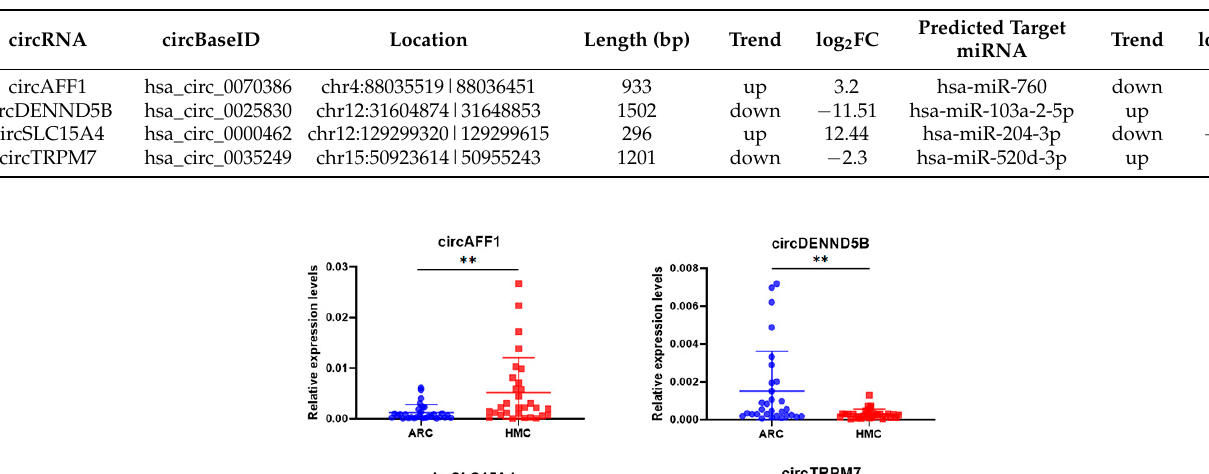
Table 3. The information of selected circRNAs.